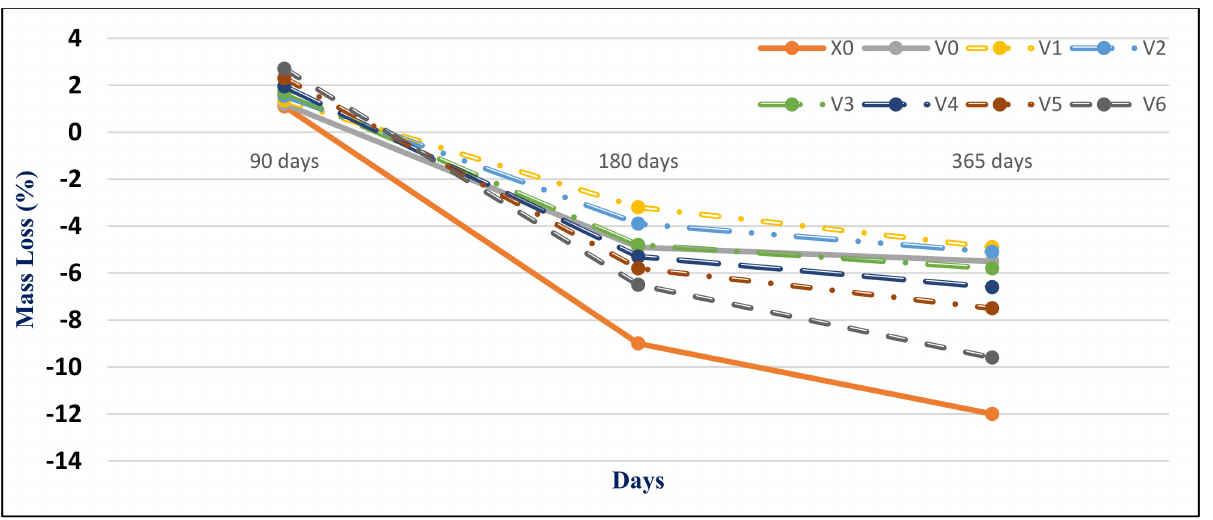
Figure 16. Group V mass loss ( ∆ Ms %) due to magnesium sulfate exposure at various curing